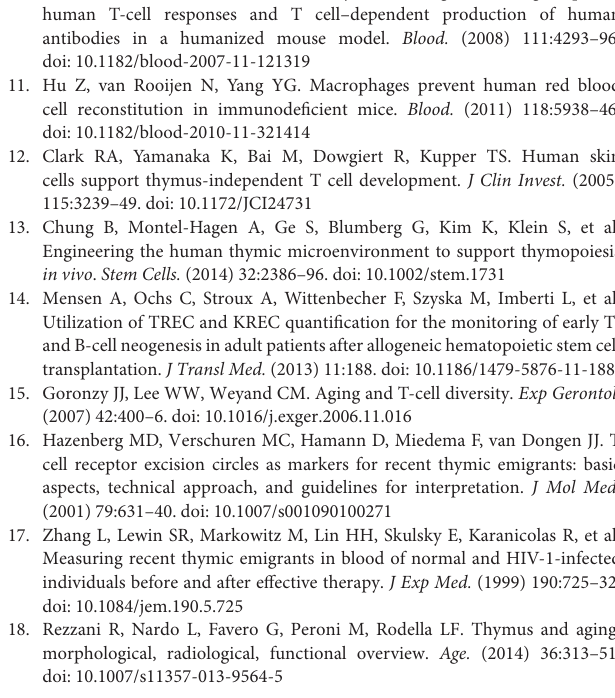
Figure S1 | CD4 + T cells are unchanged with age in healthy humans. PBMCs from 44 healthy individuals were analyzed for the ratios of CD4 + T cells. Figure S2 | EpCAM expression in human thymic grafts. Human thymic grafts prepared from hu-mice at weeks 10, 16, and 22 were analyzed for EpCAM gene expression by real-time RT-PCR analysis. Relative expression levels (normalized to β -actin) of EpCAM gene shown as the mean ± SEM ( n = 3–4 animals were analyzed at each time point). Figure S3 | AIRE and FOXN1 expression in human thymic grafts. Human thymic grafts prepared from hu-mice at weeks 10, 16, and 22 were analyzed for AIRE and FOXN1 gene expression by real-time RT-PCR analysis. Relative expression levels (normalized to β -actin) of FOXN1 (A) and AIRE (B) genes shown as the mean ± SEM ( n = 3–4 animals were analyzed at each time